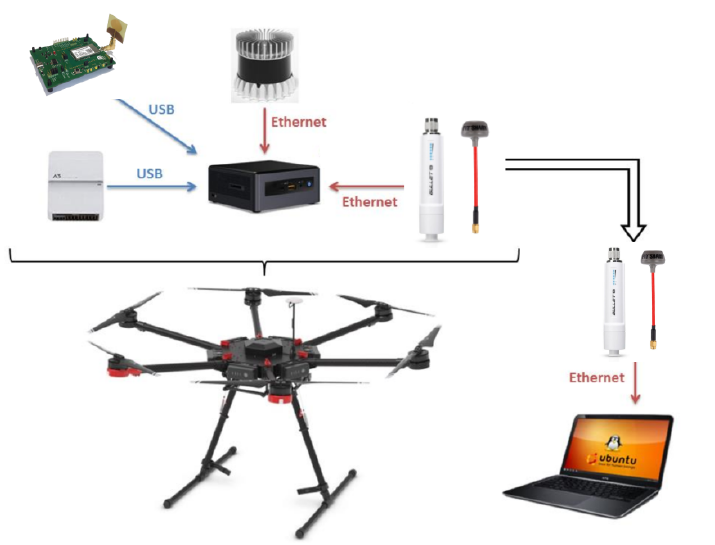
Figure 2. Hardware